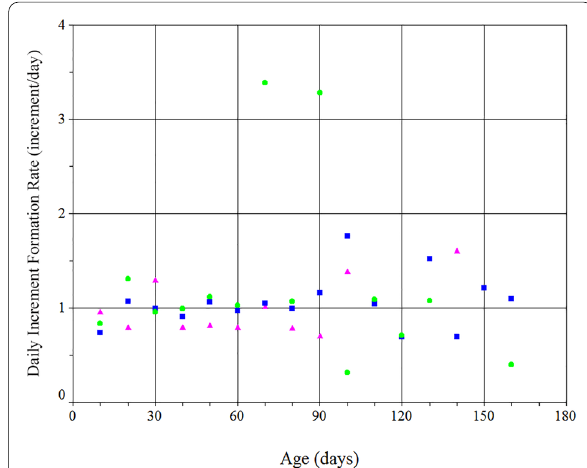
Fig. 5 Daily increment formation rate (increment/day) varied upon age (days), where maturity is from 60 days, (circle— Sepioteuthis lessoniana , rectangle— Sepia pharaonis , triangle— Sepiella inermis